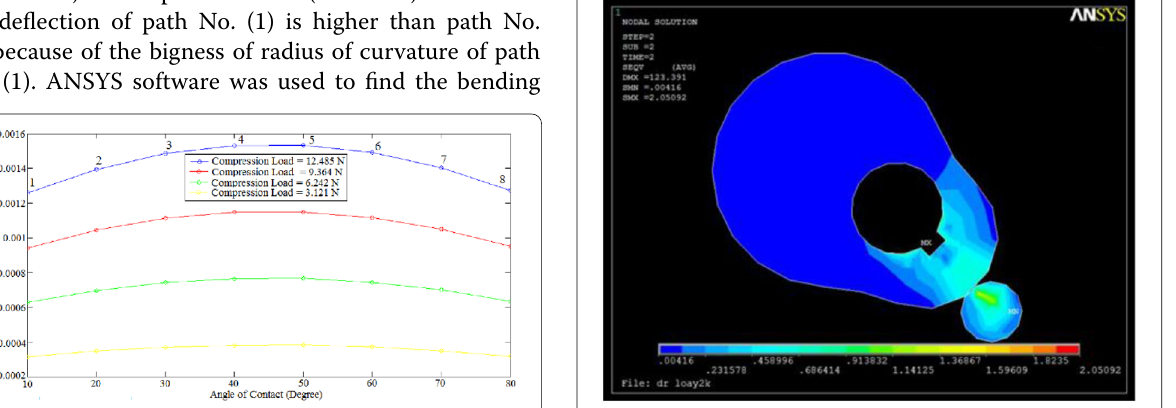
Figure 21 Contact stress contour when the follower located at 0° with the